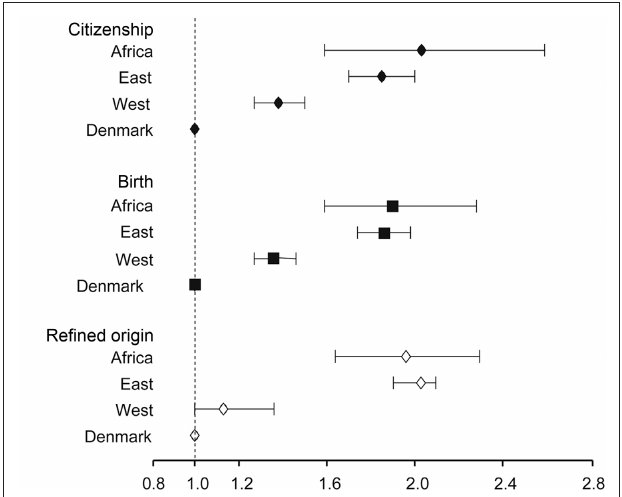
FiguRe 4 | Comparison of hazard ratios associated to use of statins according to different ethnicity parameters. Comparison of the hazard ratios obtained by Cox analysis for discontinuation of statins obtained using simple ethnic grouping by citizenship and by country of birth compared with refined grouping according to country of origin, obtained by combining individual country of birth with the parents’ country of birth.